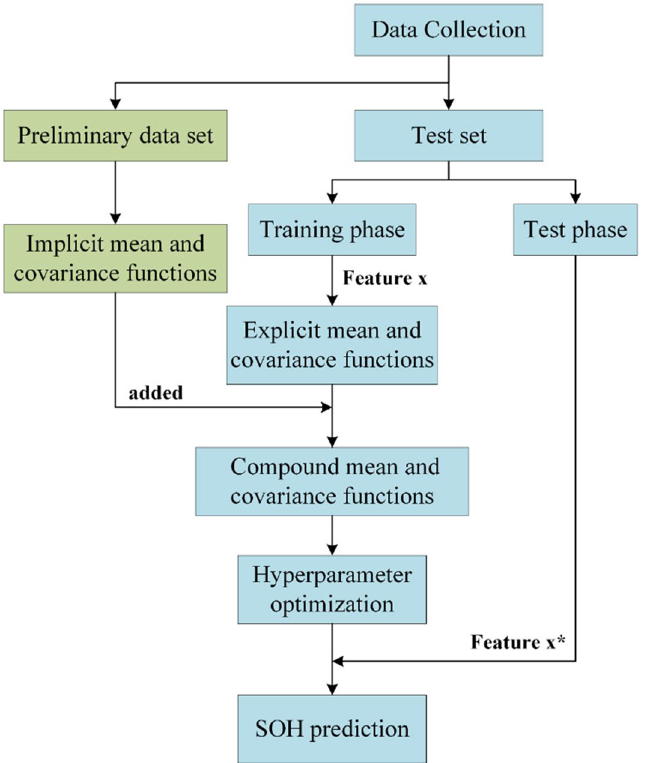
Figure 1. The workflow of SOH prediction. The blue parts correspond to the conventional methods of SOH prediction, where explicit functions are used in GPR. The green parts correspond to the GPR-implicit function model presented in this study, where the used implicit mean and covariance functions are derived from the preliminary data